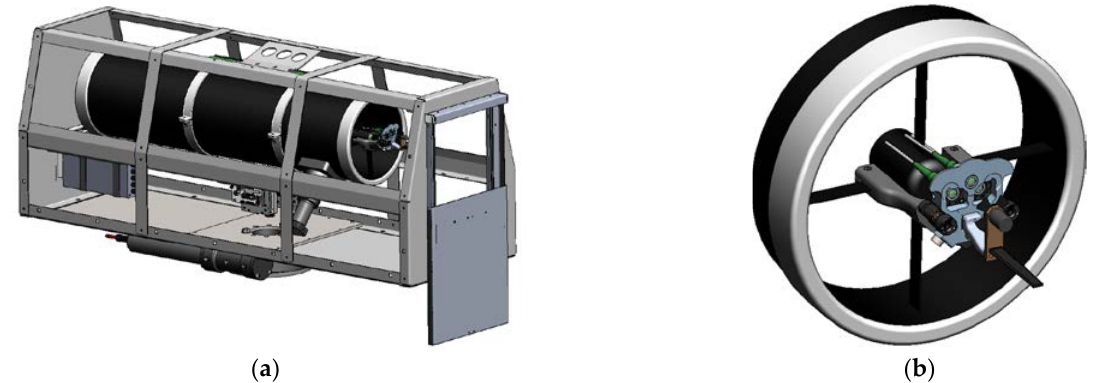
Figure 3. CAD image of the ( a ) instruments internal configuration and ( b ) laser diode collimator mount.